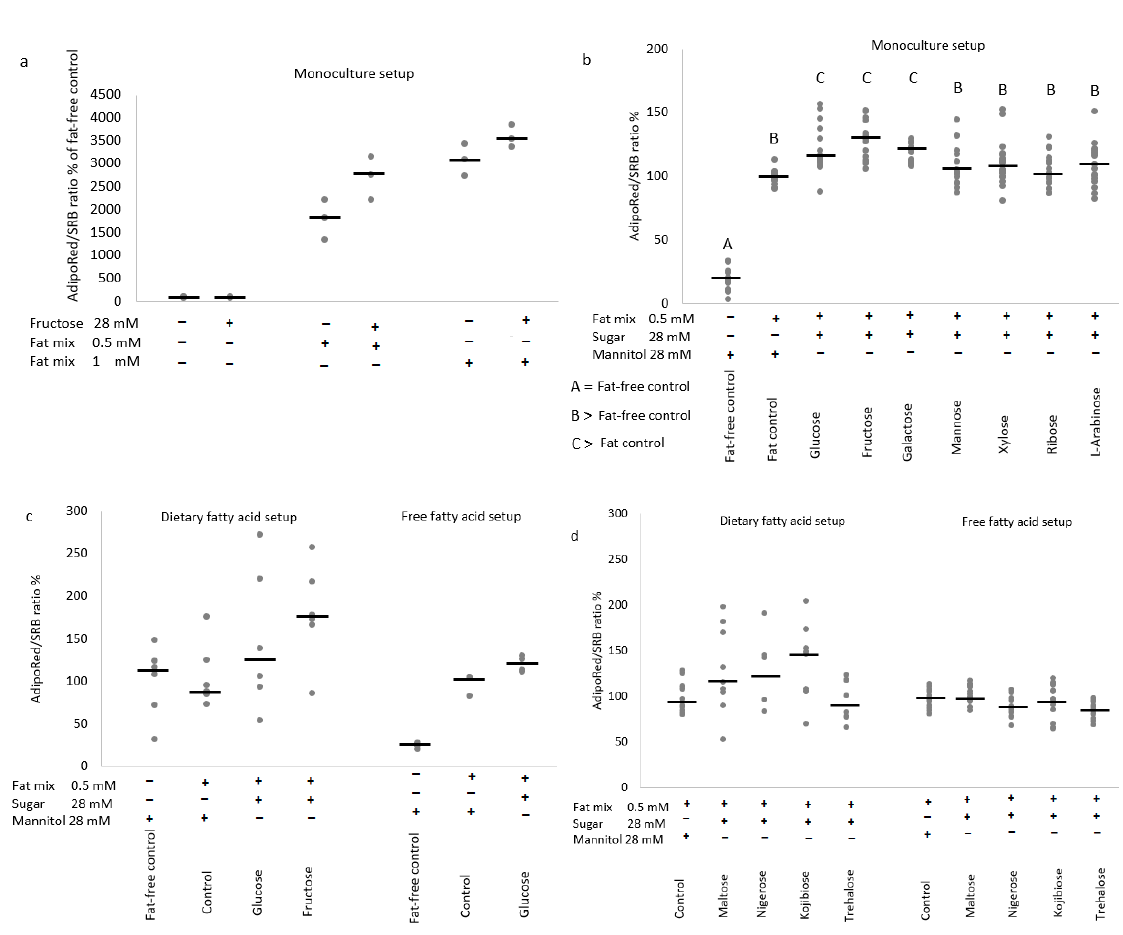
Figure 3. The effect of 24-h sugar exposures on protein-corrected AdipoRed fluorescence in mono- culture ( a , b ) and coculture setups ( c , d ) with HepG2 cells. Protein-corrected AdipoRed fluorescence as measure for intracellular fat accumulation is shown as % relative to the fat-free or fat-containing control. ( a , c ) Are proof-of-concept figures demonstrating the effects of a 1:1 palmitic/oleic mixture and enhancing effect of glucose or fructose in the different setups (generated from a single plate experiment with 3 wells per condition for the free fatty acid setup or from 2 independent plates for a total of 6 wells per condition for the dietary fatty acid setup). ( b , d) Demonstrate the effects of different monosaccharides at 28 mM in combination with 0.5 mM palmitic/oleic acid mixture in the monoculture setup ( b ), 18-well replicates spread over 3 experiments with independent plates, or different disaccharides at 14 mM + fatty acids in the dietary fatty acid setup ( d ), 10-well replicates spread over 3 experiments with independent plates and free fatty acid setup ( d ), and 15-well repli- cates spread over 4 experiments with independent plates. Data are presented as individual re- sponses + median value stripe ( c , d ), with different capital letters indicating statistically significant differences between conditions ( p < 0.05).